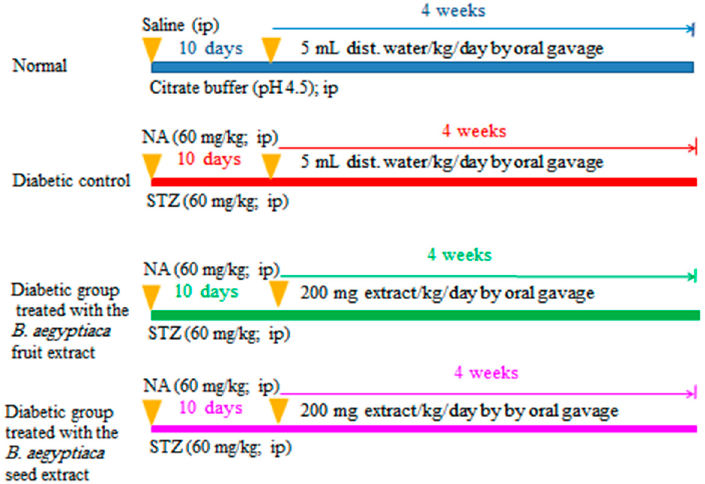
Scheme 1. Schematic figure showing the experimental design and animal grouping. NA: nicotinamide; STZ: streptozotocin; B. aegptiaca : Balanites aegptiaca ; and ip: intraperitoneal. Group I (Normal group): This group was assigned as the normal control group, and rats included in this group was given distilled water daily (5 mL/kg b.w./day) via oral gavage for 4